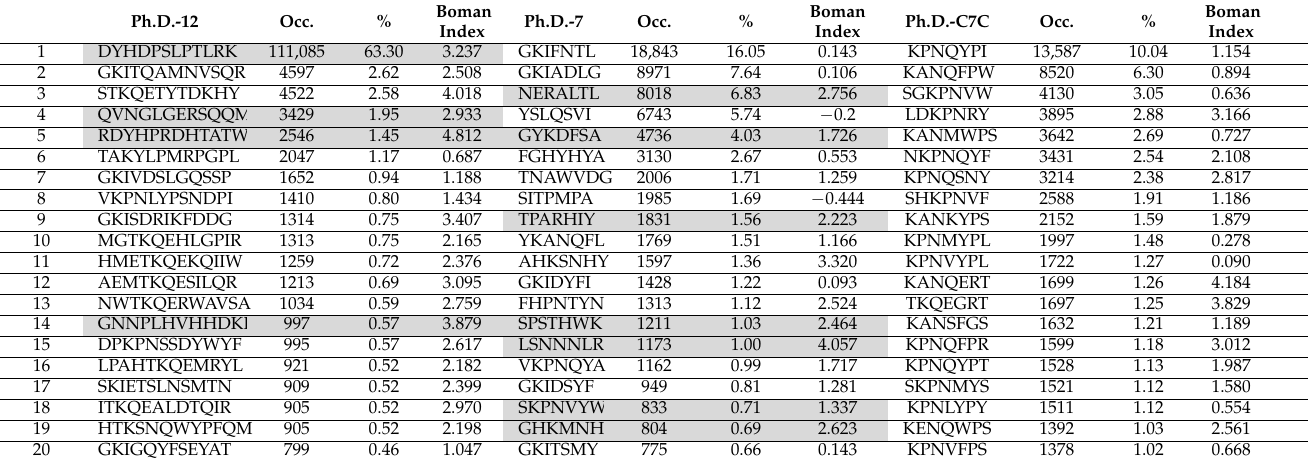
Table 2. List of 20 most abundant sequences from each Ph.D. library after the third panning round. Sequences and their abundances were obtained by the PuLSE software. Sequences highlighted in gray also appeared in naïve library or BDB database (detected by SAROTUP tools) and are regarded as TUPs. All data were normalized prior to analysis. Boman indices for peptides from the cyclic library were calculated with the addition of one cysteine on each end of the peptide. A peptide has high binding potential if the Boman index value is higher than 2.48.